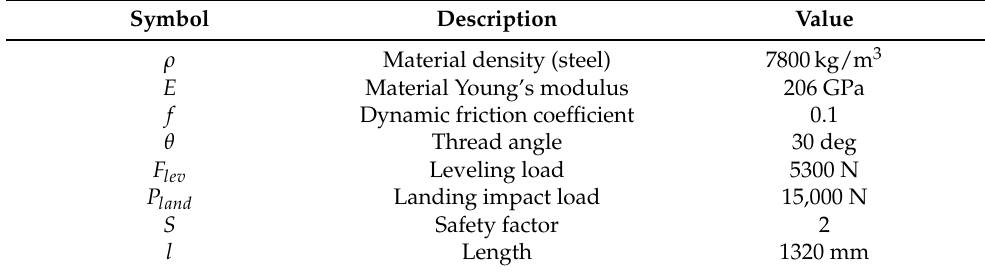
Table 1. Screw input design parameters.